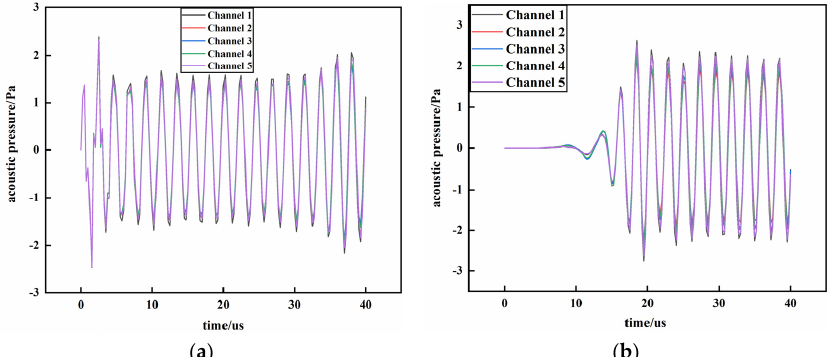
Figure 5. ( a ) Five-channel incident sound pressure change; ( b ) five-channel exit sound pressure change.